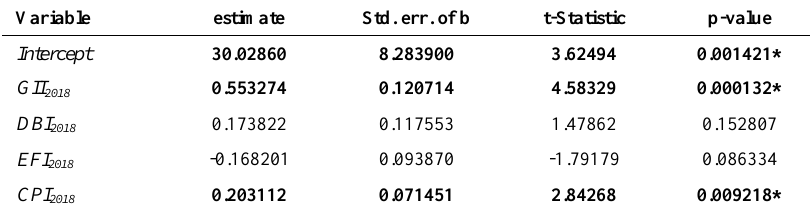
Table 7. The statistical output of the estimated variables for GCI score in 2018 Variable